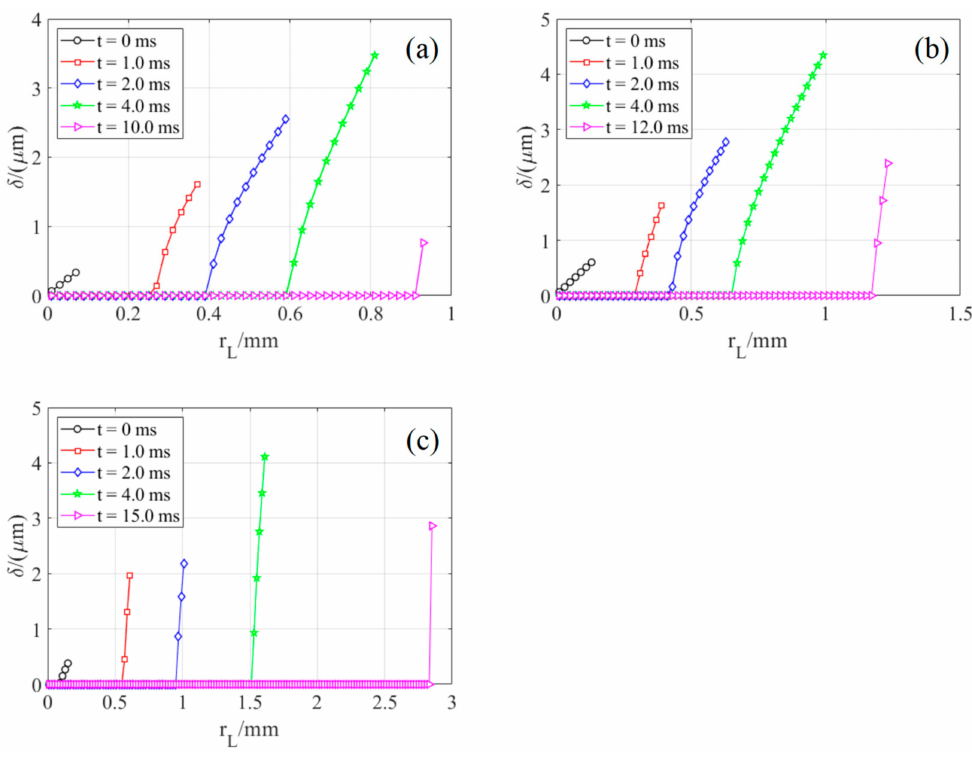
Figure 16. Thickness distribution of micro-layers at different times on: ( a ) bared ITO heater at ◦ C; ( b ) bared ITO heater at ∆ T ∆ T w = 7.22